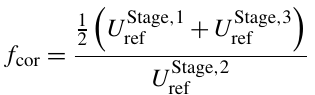
Figure A1. Induction correction factor for the measured reference wind speed of the 4R-V29 wind turbine.